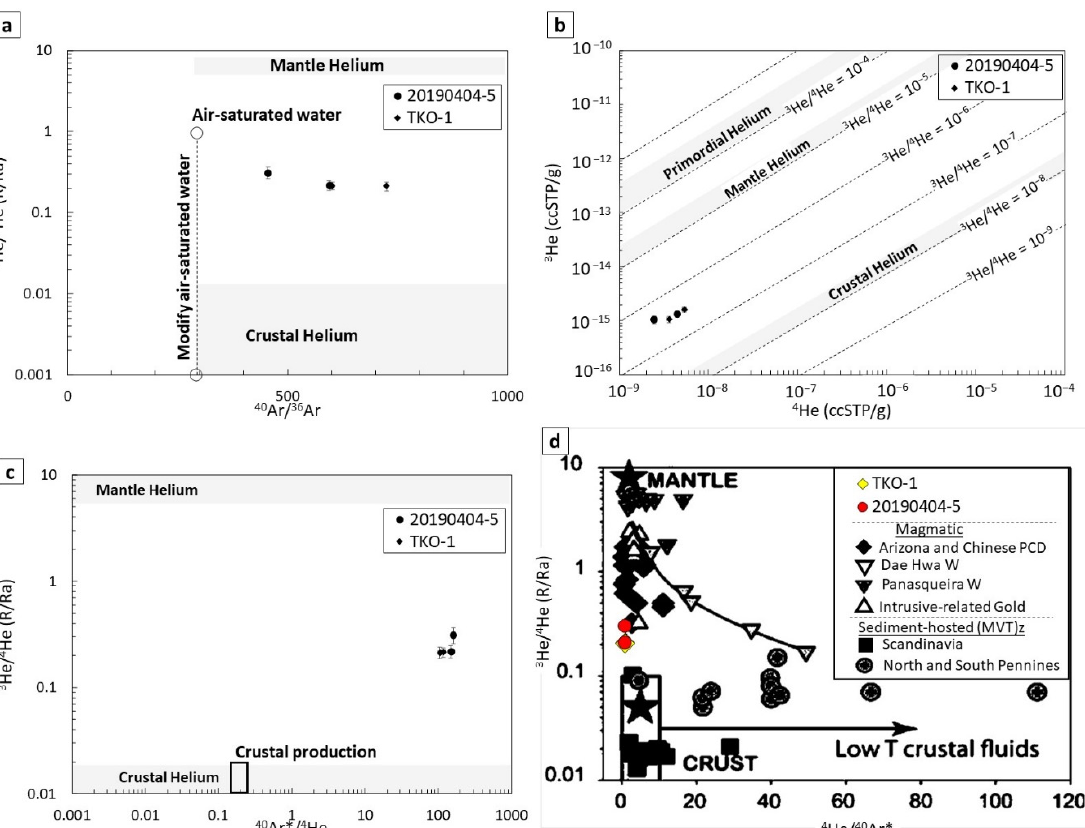
Figure 4. Correlation diagrams of noble gas isotopic composition from fluid inclusions trapped inside quartz separate samples at the Thongkai-Ok Au deposit: ( a ) plot of 3 He/ 4 He (R/Ra) vs. 40 Ar/ 36 Ar; ( b ) He isotopic compositions; ( c ) 3 He/ 4 He vs. 40 Ar*/ 4 He. Concentration of 40 Ar* compared with the atmospheric 40 Ar/ 36 Ar = 296.0 was calculated by 40 Ar* = ( 40 Ar/ 36 Ar – 296.0) × 36 Ar; ( d ) Correlation diagram of 3 He/ 4 He vs. 4 He/ 40 Ar*, comparing the Thongkai-Ok hydrothermal fluid with selected magmatic- and formation water-derived ore fluids (modified from Kendrick and Burnard, 2013) [16]. The stars represent the mean mantle and crustal production ratios, and the rectangle box represents the range of crustal components.